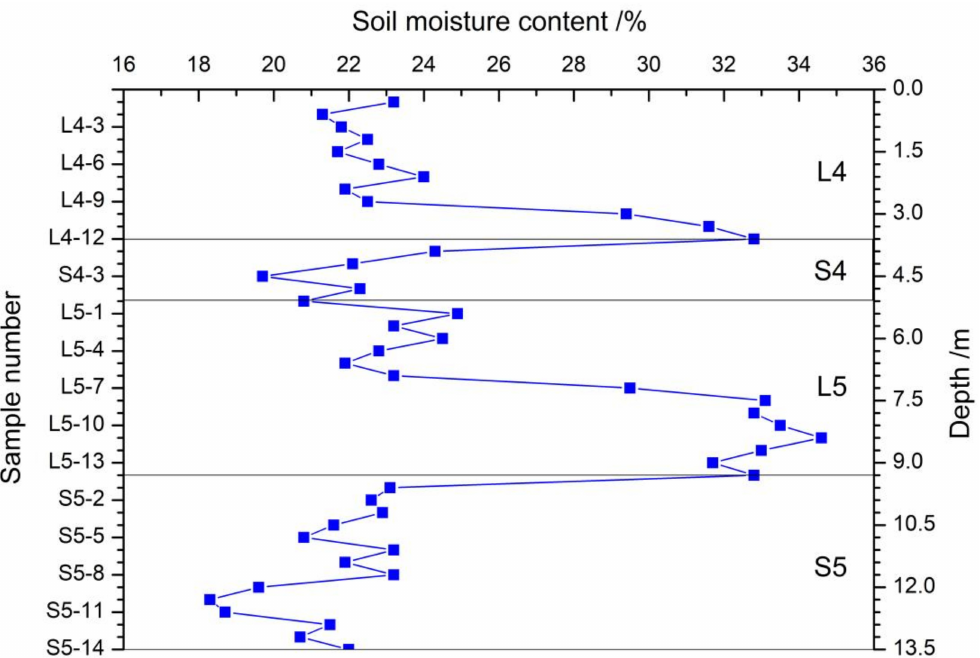
Figure 5. The line chart of soil moisture content (mass ratio) in the loess strata (L4-S5) of the study